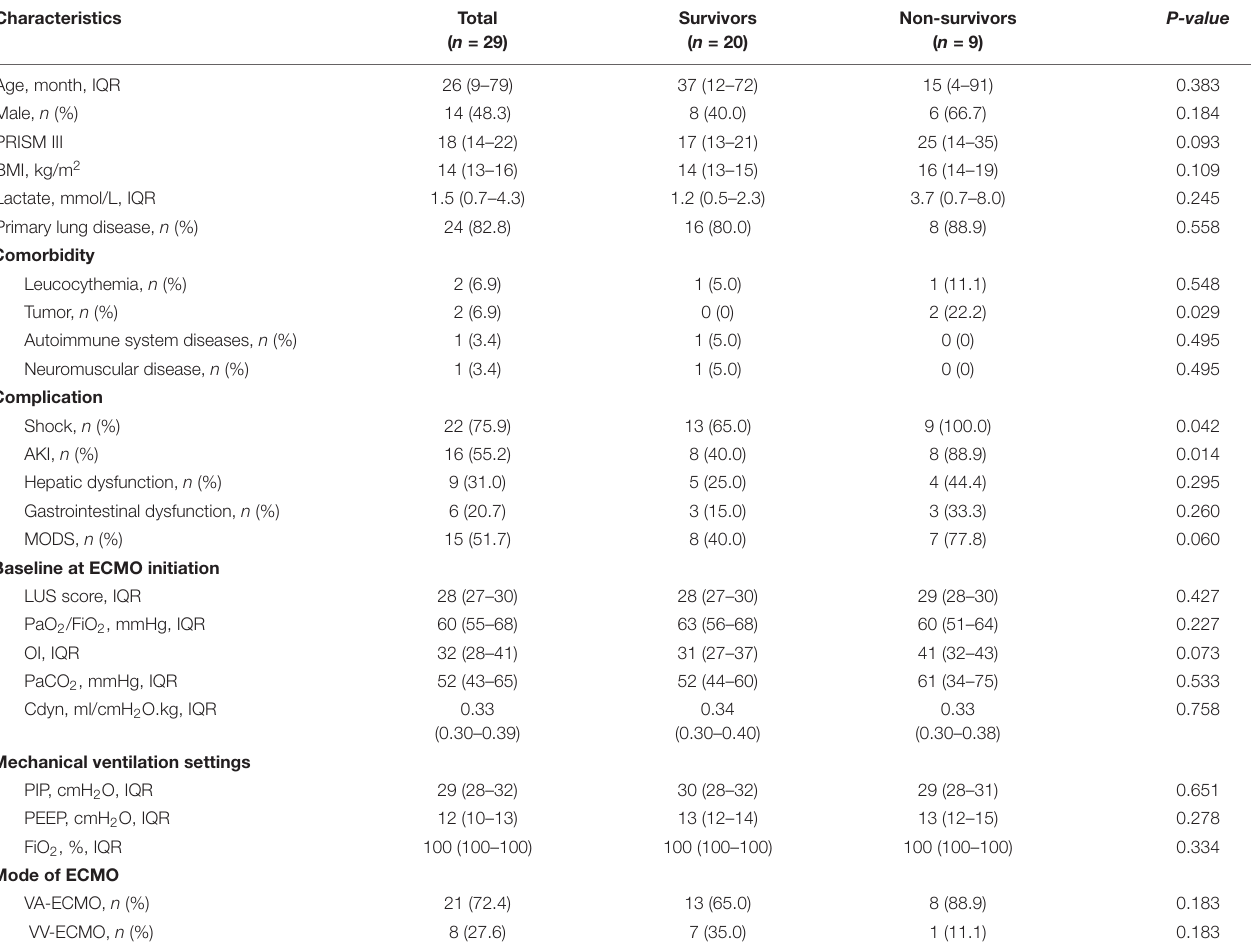
TABLE 1 | Baseline characteristics of patients at initiation of ECMO